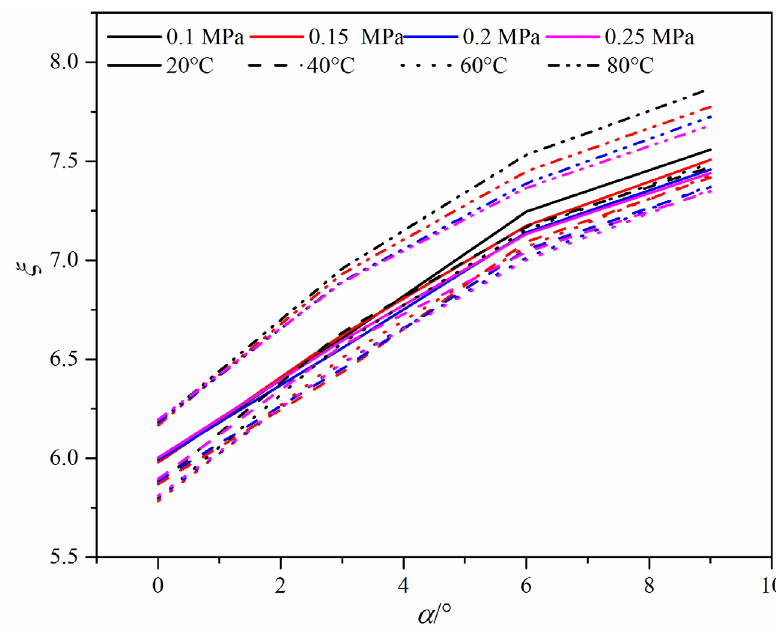
Figure 12. Loss coe ffi cient in the two-cage globe valve with di ff erent installation angles. Figure 12. Loss coefficient in the two-cage globe valve with different installation angles.